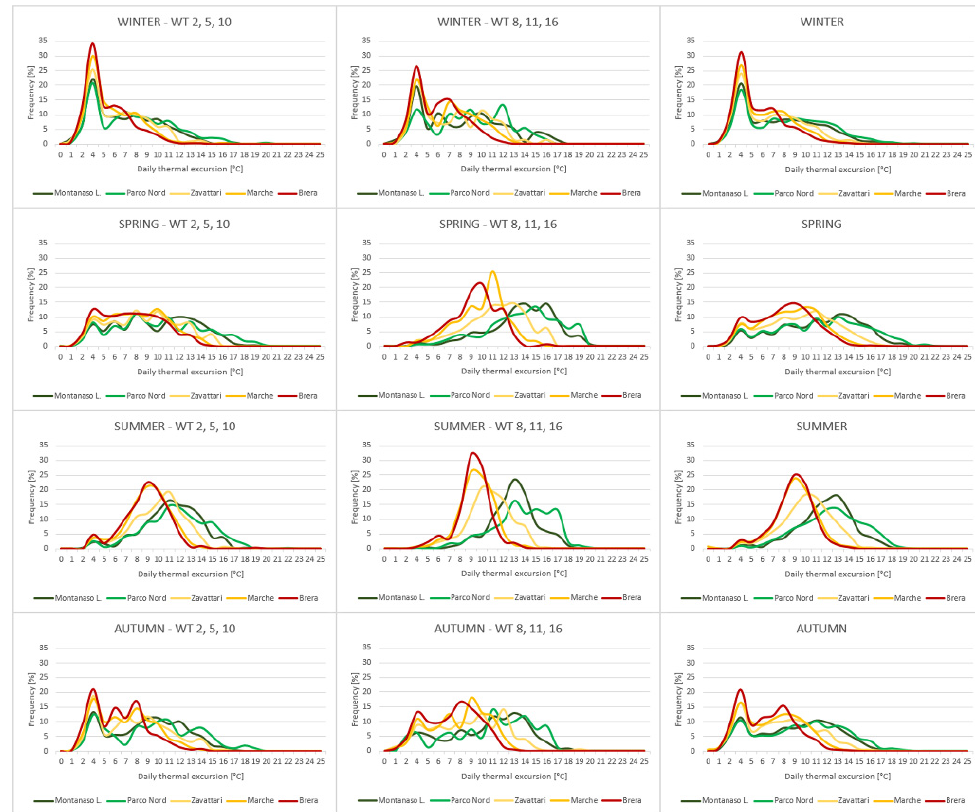
Figure 3. Distribution of the seasonal daily thermal range (DTR) for the five weather stations.